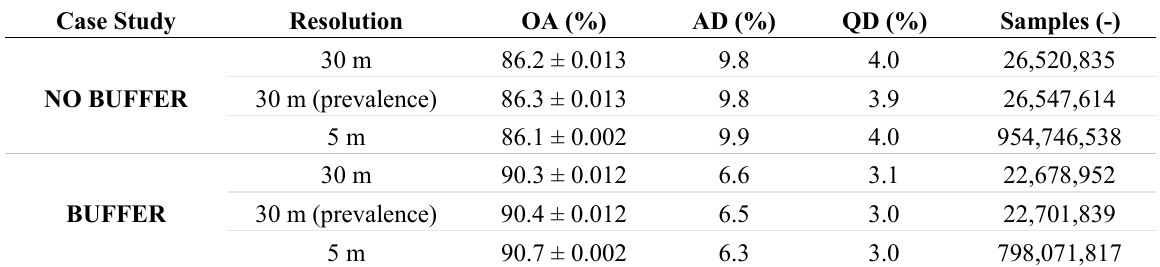
Table 8. Comparison between GlobeLand30 2010 and DUSAF4.0 (I classification): overall statistics and number of samples for the two cases of no buffer and buffer and for different resolutions. OA: overall accuracy (confidence intervals at 95% probability); AD: allocation disagreement; QD: quantity